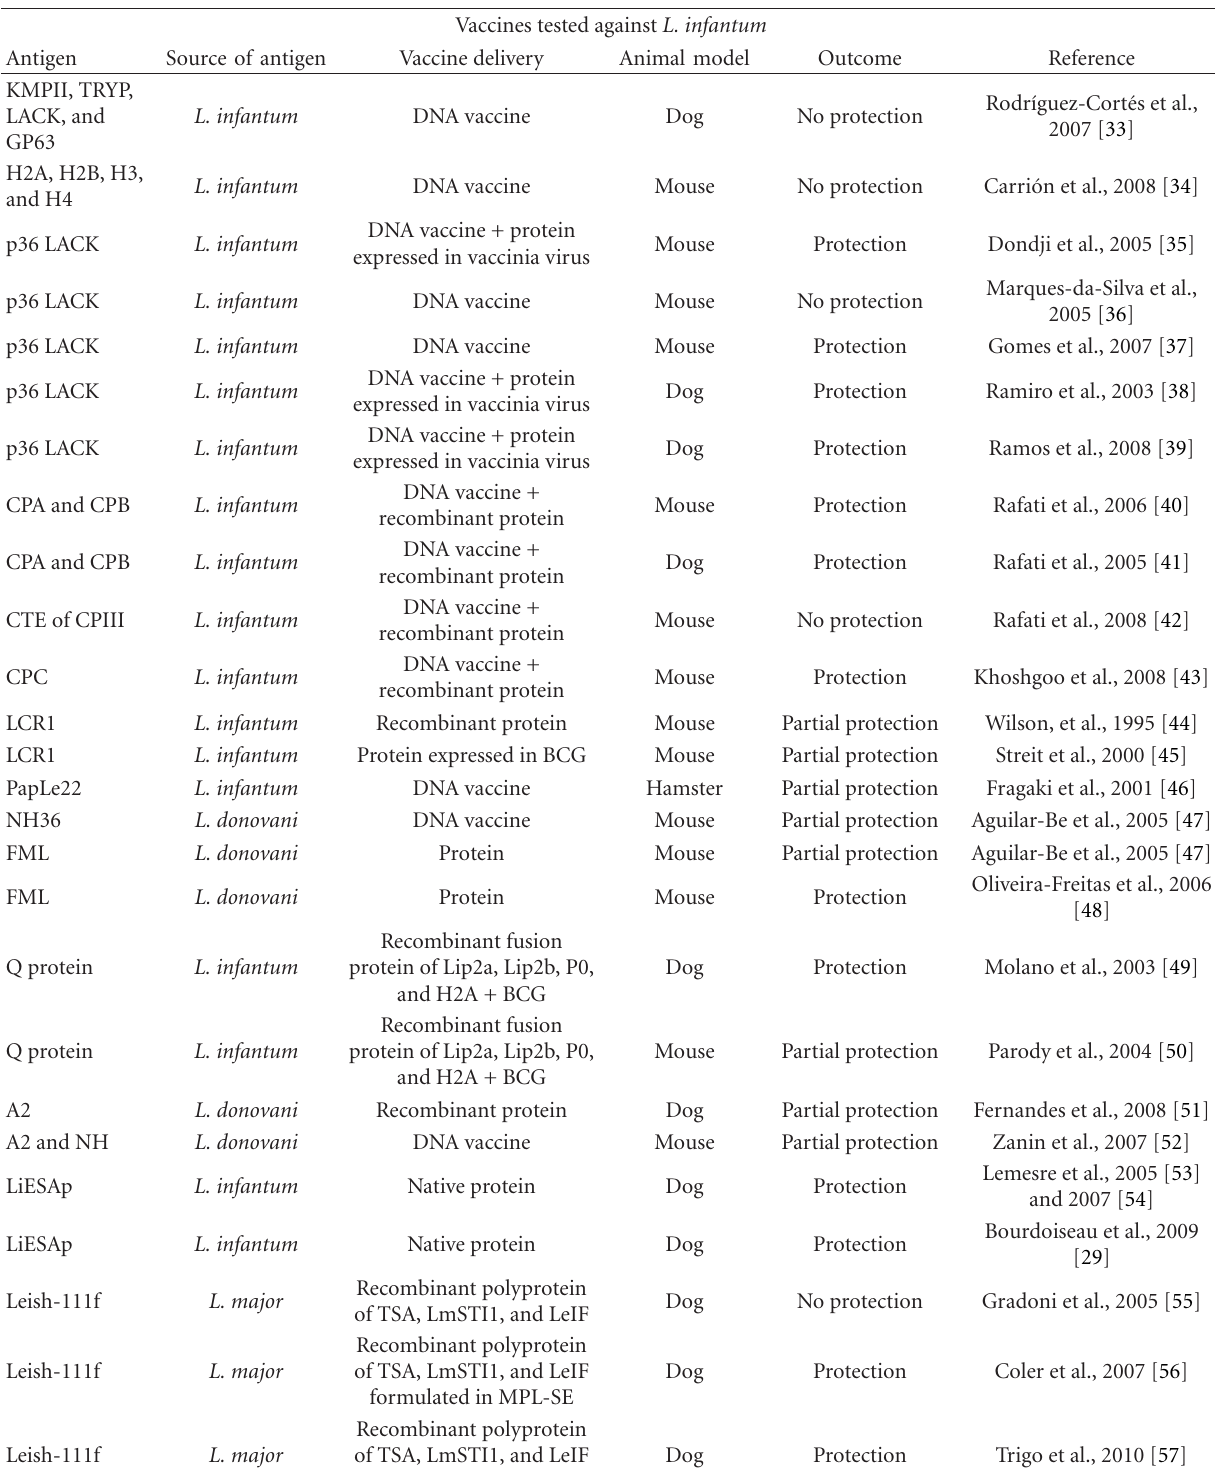
Table 1: Vaccines against visceral leishmaniasis. (a) Vaccines tested against L.